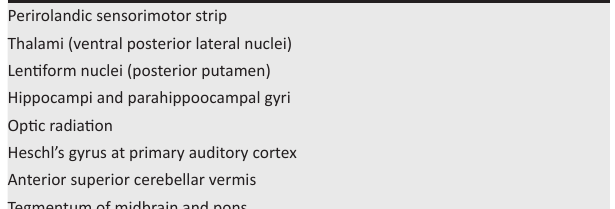
TABLE 3: High metabolic zones of the brain with highest concentration of N-methyl-D-aspartate receptors.